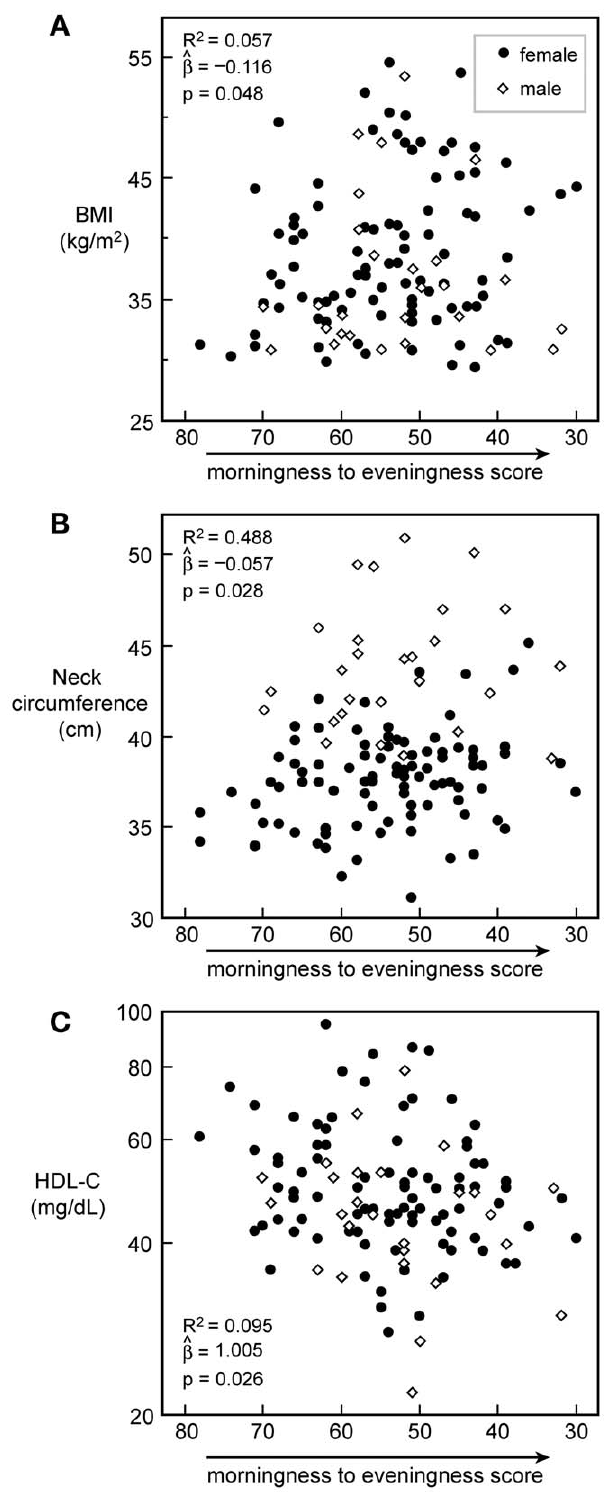
Figure 3. Anthropometrics and HDL-C vs. chronotype score. Plot of Chronotype scores versus BMI (A), neck circumference (B), and HDL-C (C) with a trend line, respectively. N=119 for all. R 2 slope, and p - value for the prediction of chronotype score on variables in each plot are calculated from gender-corrected models. Closed circles represent women, open diamonds represent